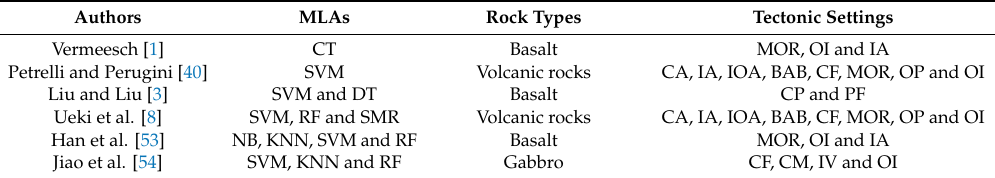
Table 1. A summary of ML models and application scenarios in a few